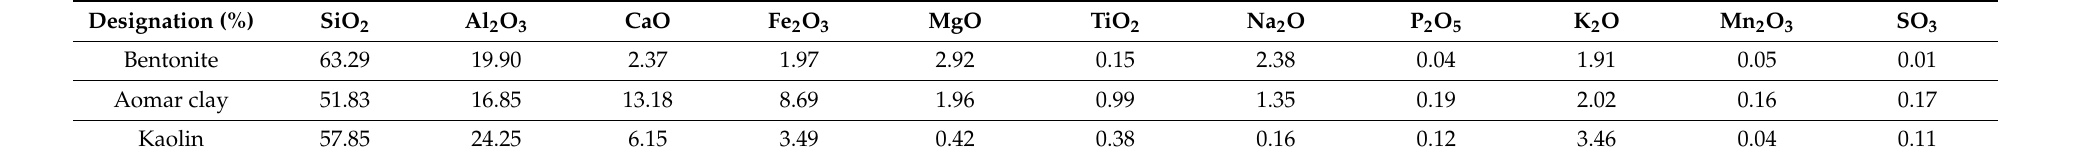
Table 2. Chemical composition of the clays in mass percentage(W%).